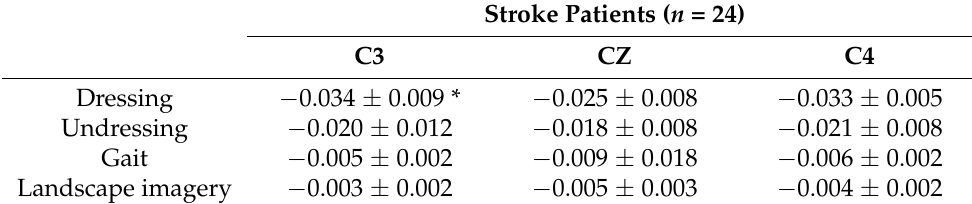
Table 2. Average mu power log ratio of action